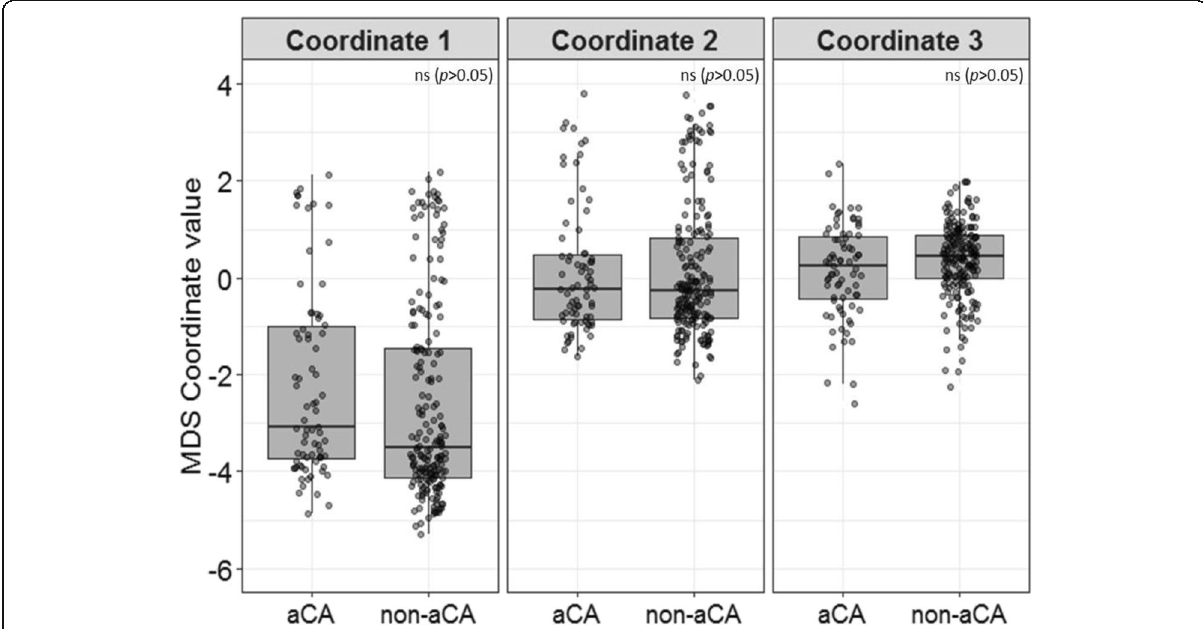
Fig. 1 Distribution of ancestry MDS coordinates in the study cohort. The three ancestry MDS coordinates were not significantly different between the aCA cases and non-aCA cases in the study cohort, suggesting pathology was not confounded by ancestry in our study population. p -values were calculated by Kolmogorov-Smirnov